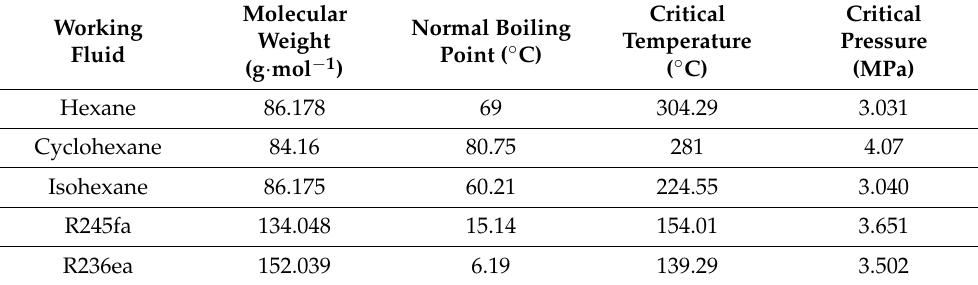
Table 3. Properties of the five organic working